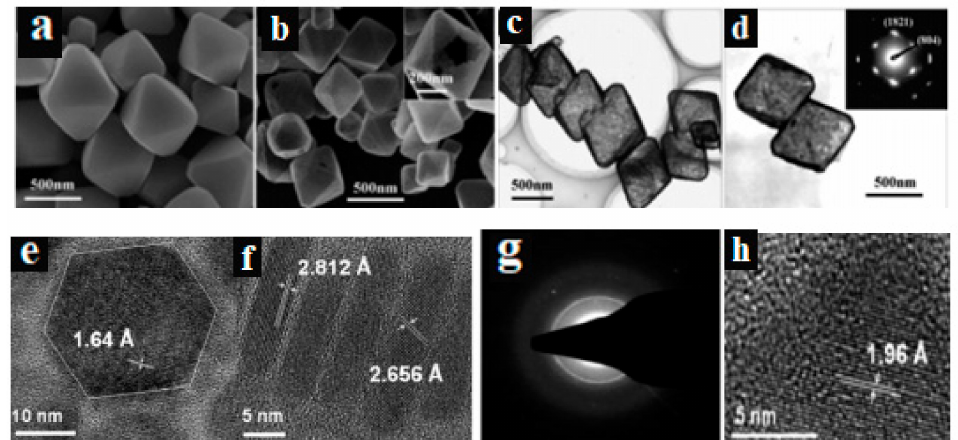
Figure 3. Morphology images of ( a ) octahedral Cu2O crystals, ( b ) octahedral CuxS cages, ( c ) TEM octahedral and ( d ) the SAED pattern of octahedral (reproduced from ref. [41] with permission from the American Chemical Society); ( e , f ) are for the sample prepared using 10 mM solution of the precursor at 200 °C for 1h showing flat and standing hexagonal nanodisks and ( g ) SAED. ( h ) TEM images for the sample prepared using 20 mM solution of the precursor at 280 °C (reproduced from ref. [42] with permission from the American Chemical